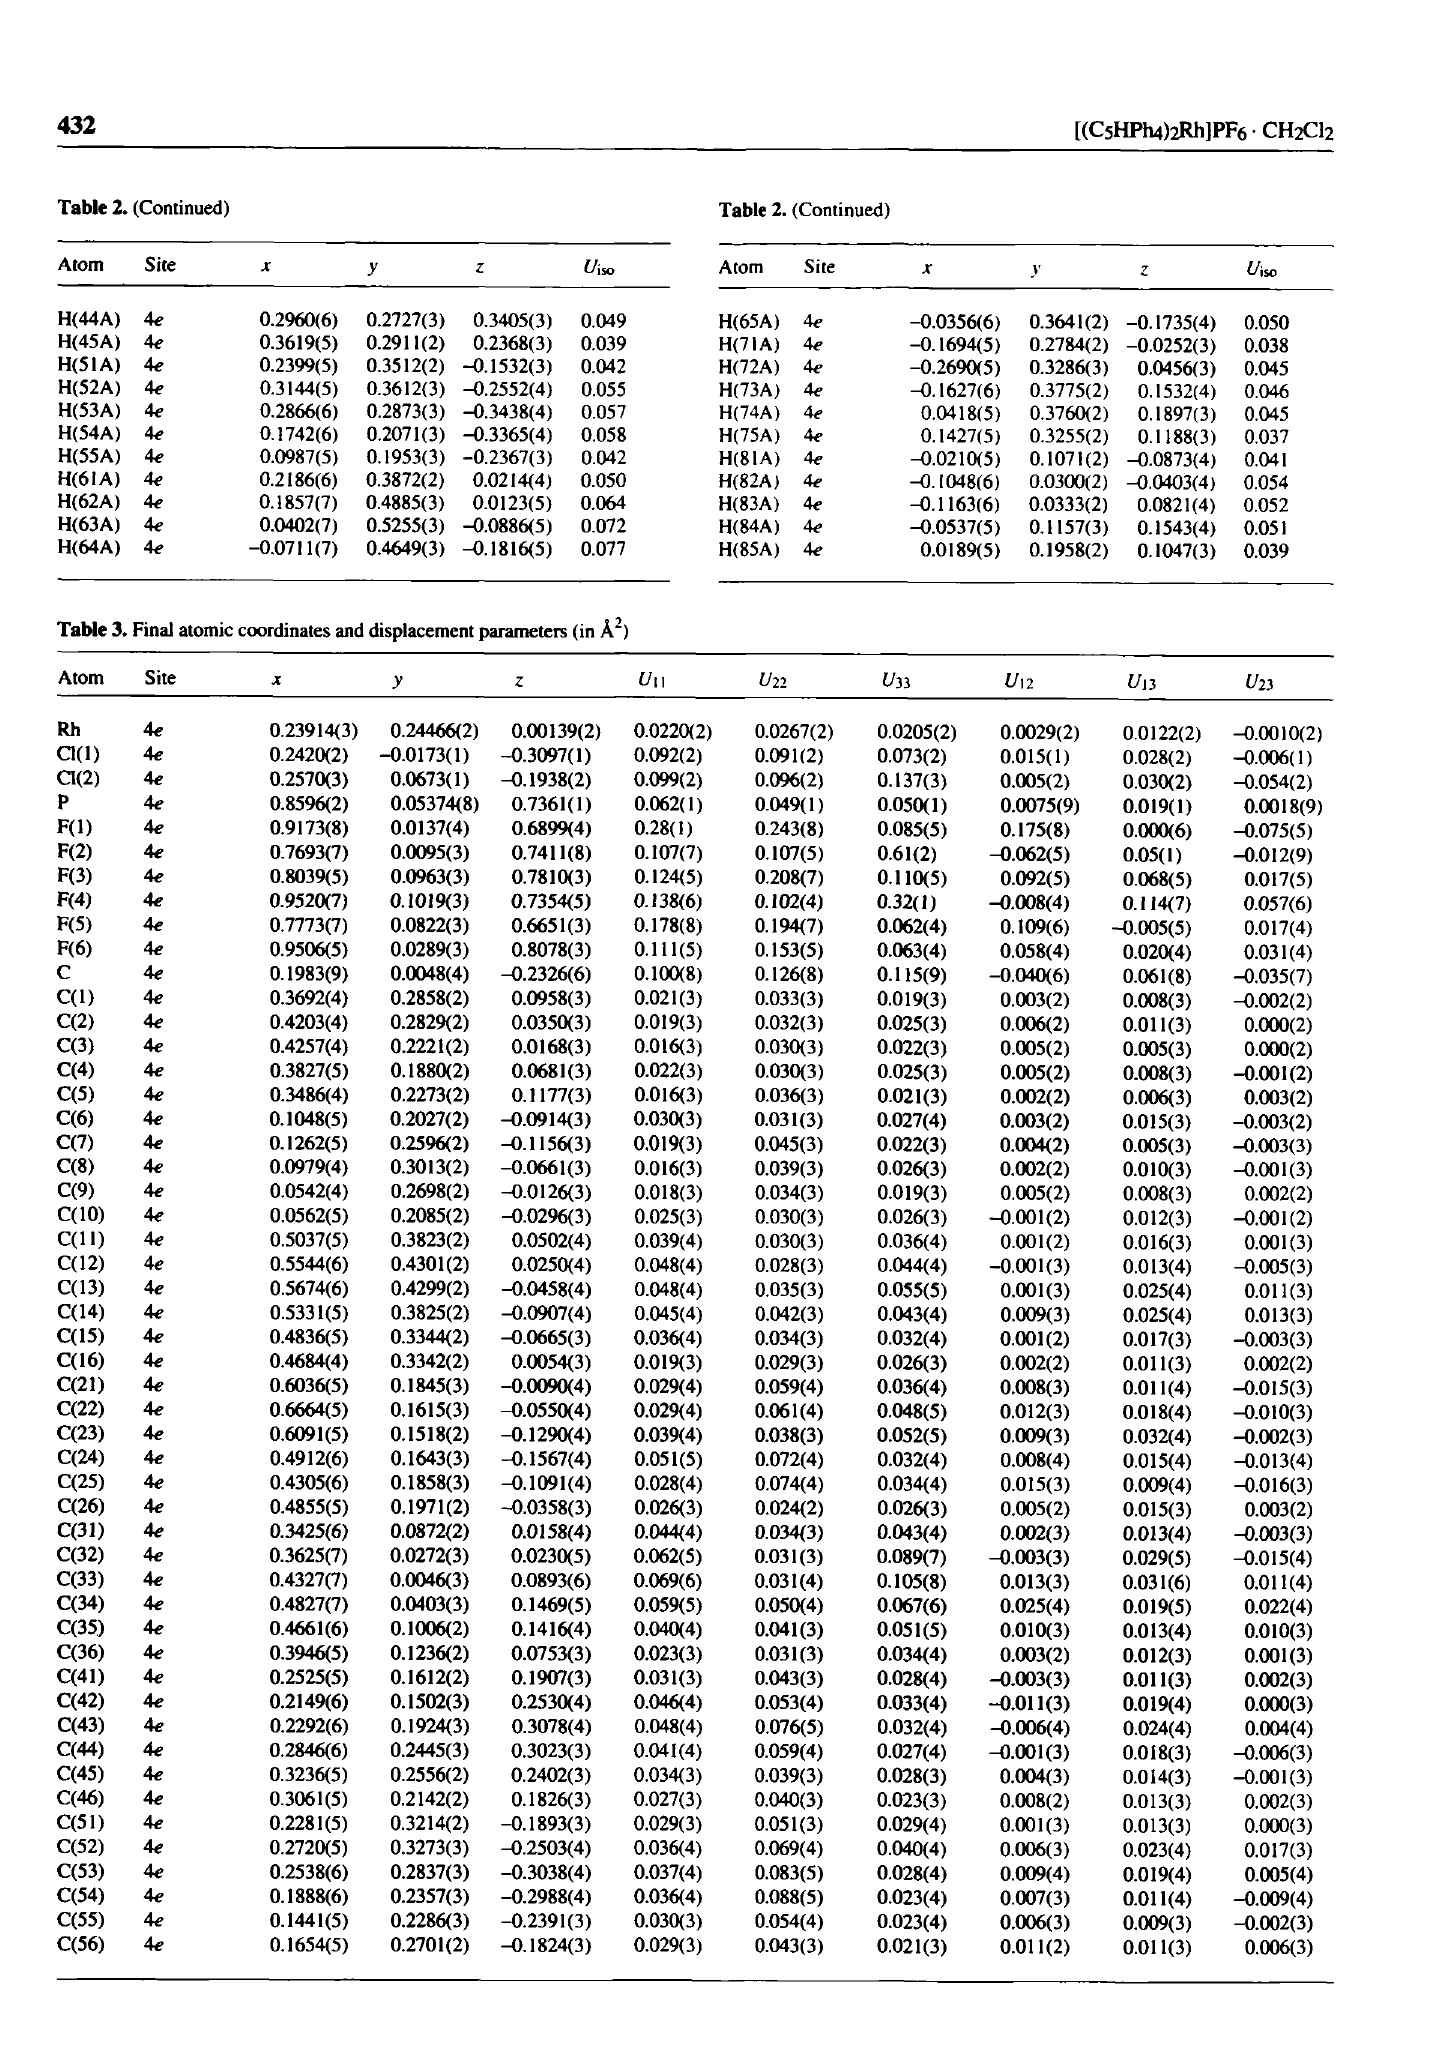
Table 3. Final atomic coordinates and displacement parameters (in Â^) Atom